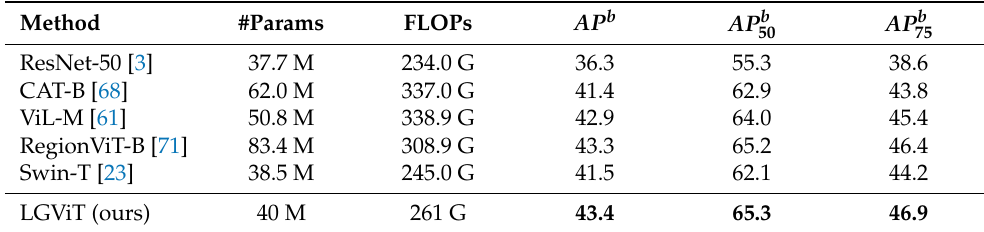
Table 4. Performance comparison of object detection task on the COCO2017 dataset for different models with RetinaNet. The FLOPs are computed on 1280 × 800 resolution.